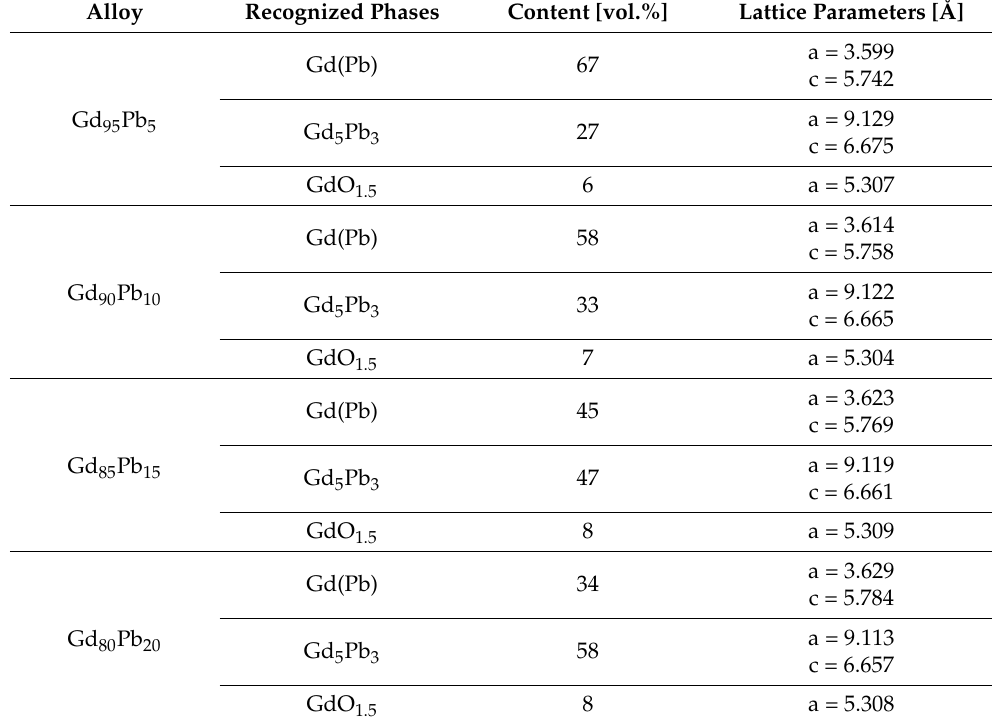
Table 1. The results of the Rietveld analysis.